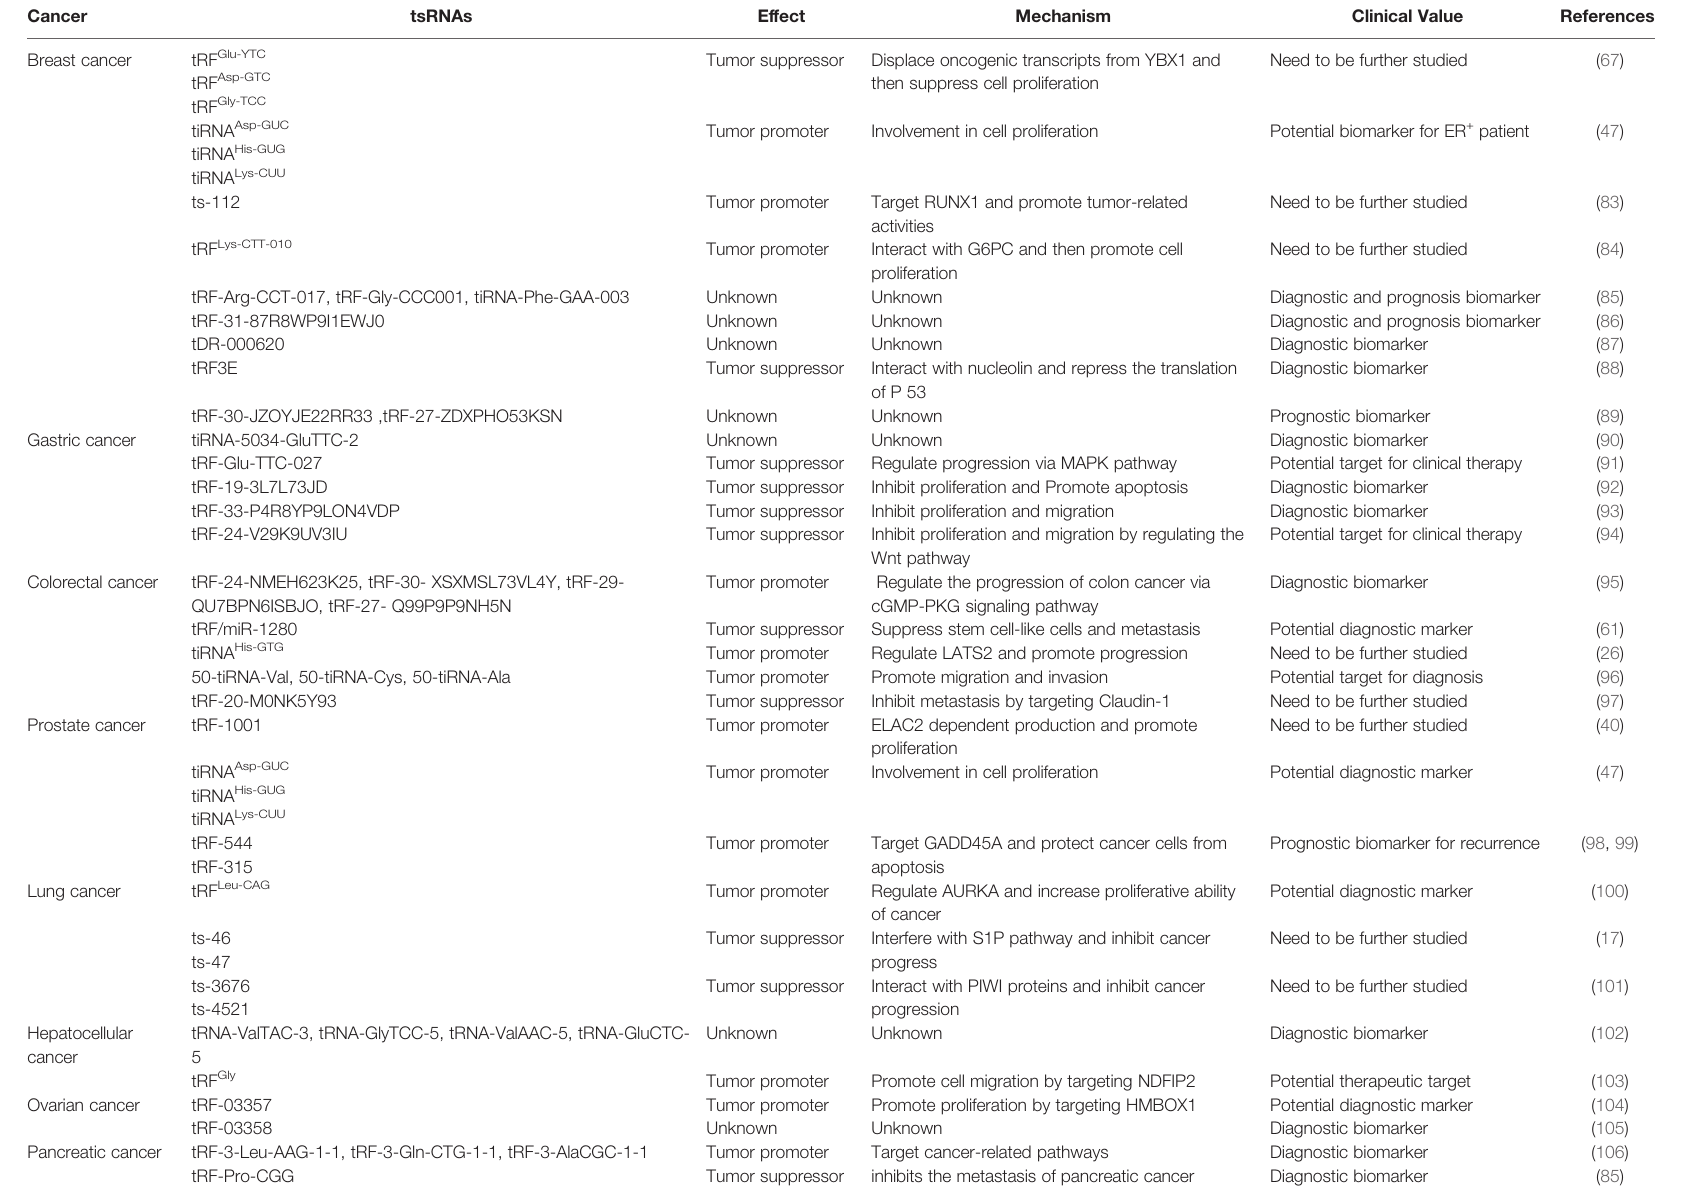
TABLE 2 | Summary of cancer-associated